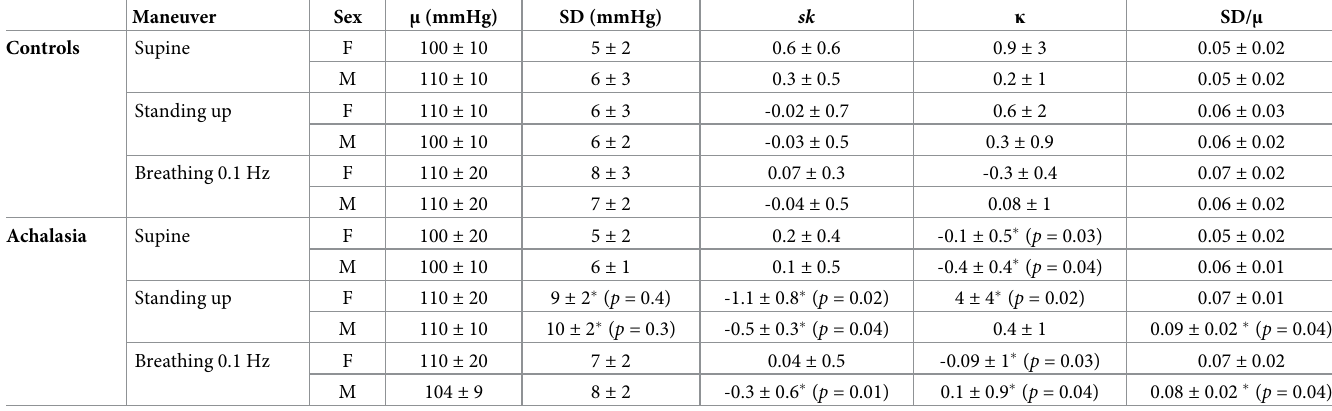
Table 2. Systolic blood pressure in the time domain.